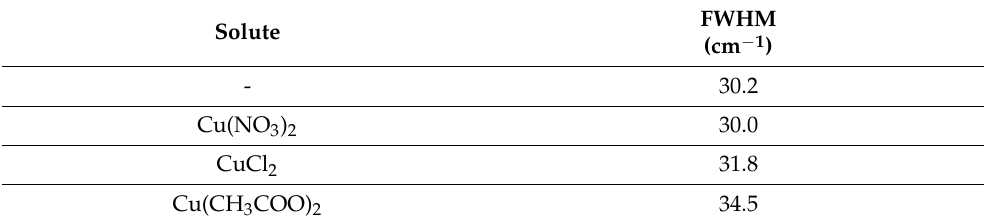
Figure 3. Raman spectra of undoped (black) TiO 2 and TiO 2 doped with nitrate (blue), chloride (green), and acetate (red). The spectral intensity was normalized. Table 1. Dependence of FWHM values on Cu salt species. Table 1. Dependence of FWHM values on Cu salt species.